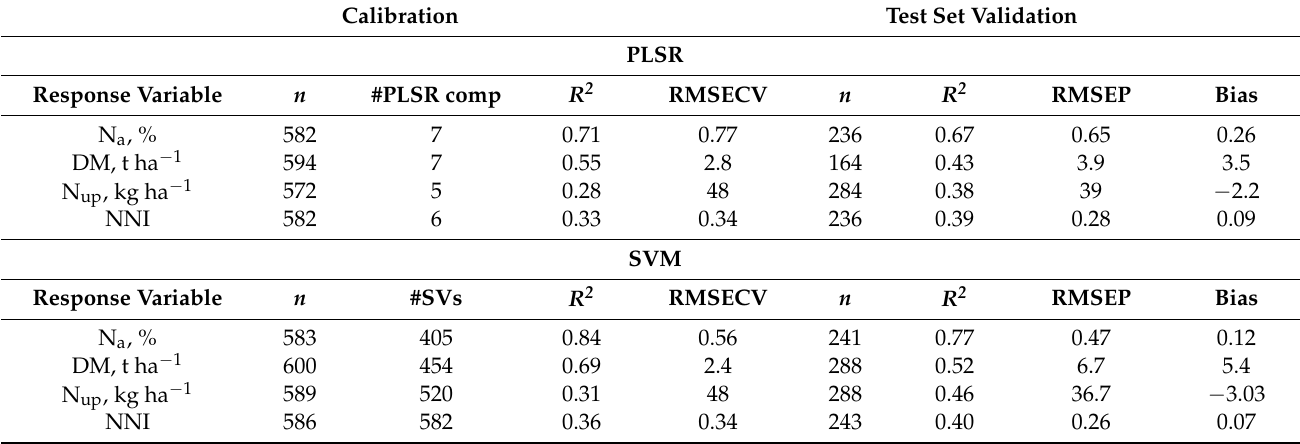
Table 5. Calibration and validation statistics of PLSR and SVM models on a combination of raw wavelengths and vegetation indices for determination of N concentration (N a ), dry matter (DM), N uptake (N up ) and N nutrition index (NNI). Units for RMSECV and RMSEP are similar to the units defined for each response